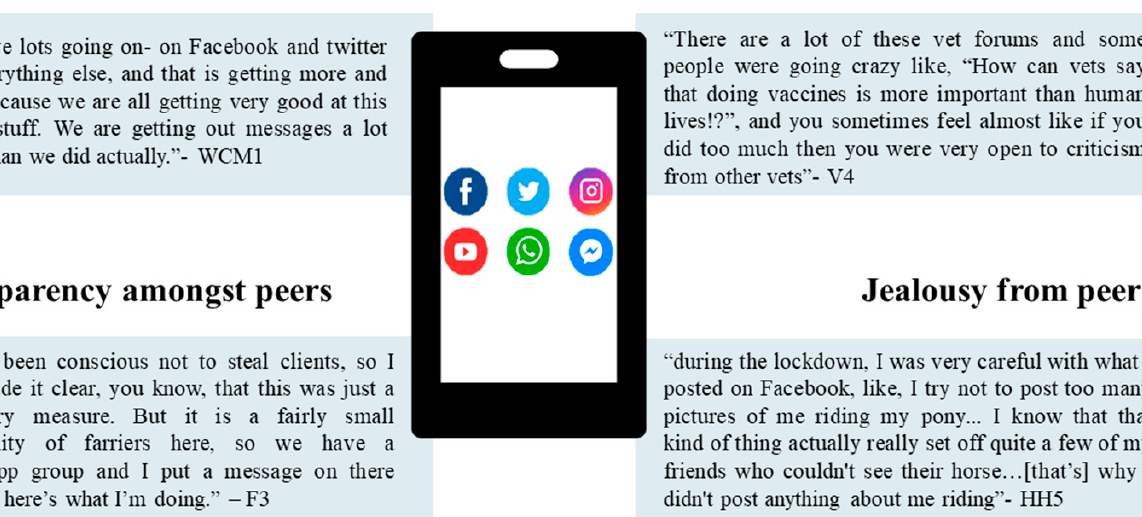
Figure 2. Negative and positive aspects of social media use within the equestrian, farrier, and veterinary community during the first phase of lockdown.